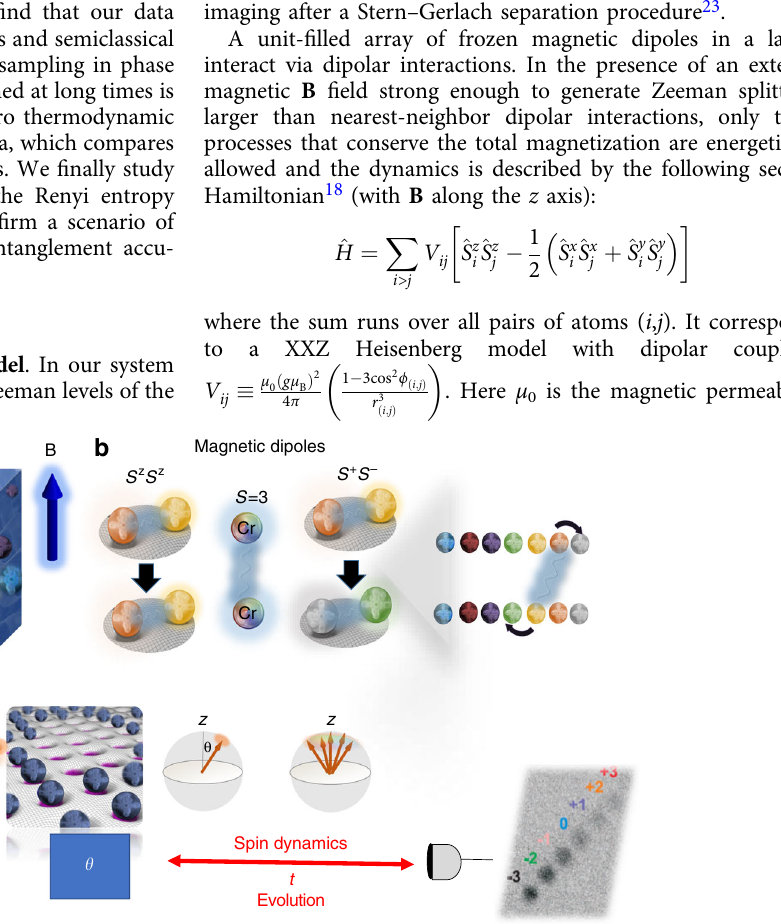
Fig. 1 Sketch of the experiment. a We consider an assembly of S = 3 Cr atoms in an optical lattice prepared in a Mott-insulating state. b Dynamics is driven by dipole – dipole interactions which feature both Ising ð ^ S z i ^ S z j Þ and exchange ð ^ S þ i ^ S (cid:2) j þ h : c Þ terms. c A fi rst π pulse is used to promote all atoms to the most excited spin state. Dipolar relaxation empties doubly occupied sites. Once this is achieved, a second pulse collectively rotates all spins by an angle θ from the external magnetic fi eld B which sets the quantization direction. We then study spin dynamics due to intersite dipole – dipole interactions by registering the relative populations of the different Zeeman